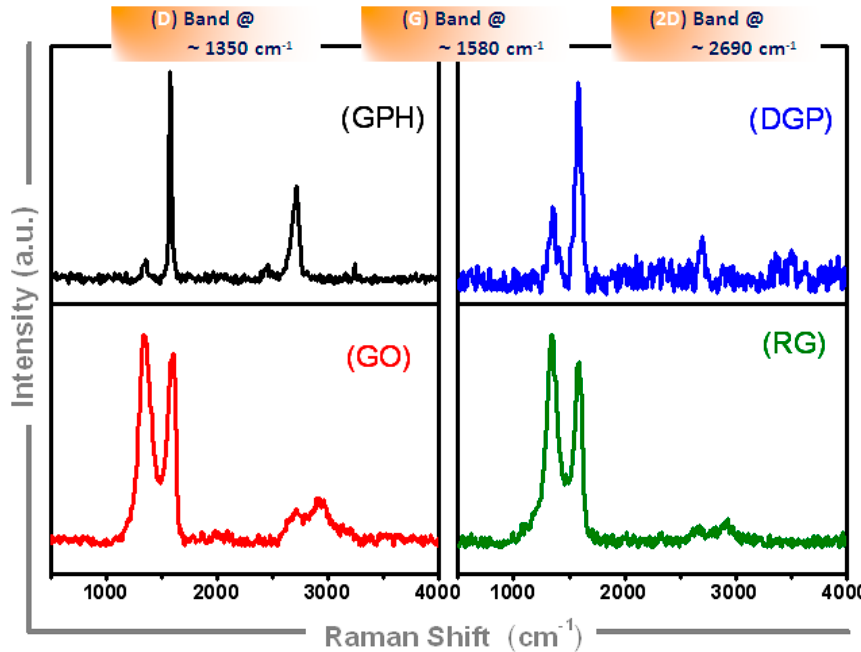
Figure 1. Raman spectra of graphite (GPH), dispersed graphene platelets (DGP), graphene oxide (GO) and reduced graphene oxide (RG).